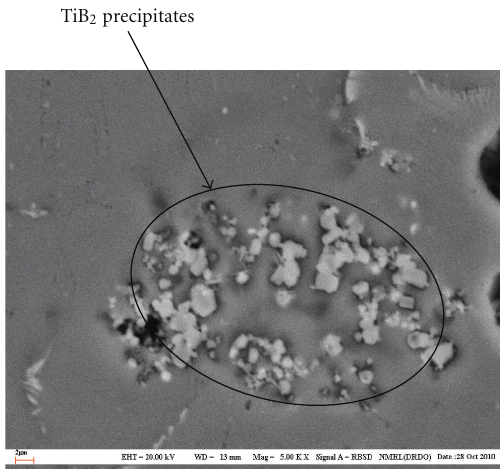
Figure 3: SEM micrograph shows magnified image of segregated pockets of TiB 2 in aluminium matrix at